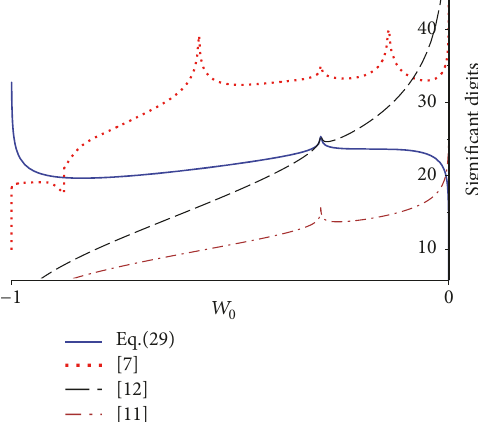
Figure 3: Significant digits for (29) and other ones reported at [7, 11, 12] after a single pass of iterative scheme of (30) for the interval of 𝑥 = [− exp (−1),0]